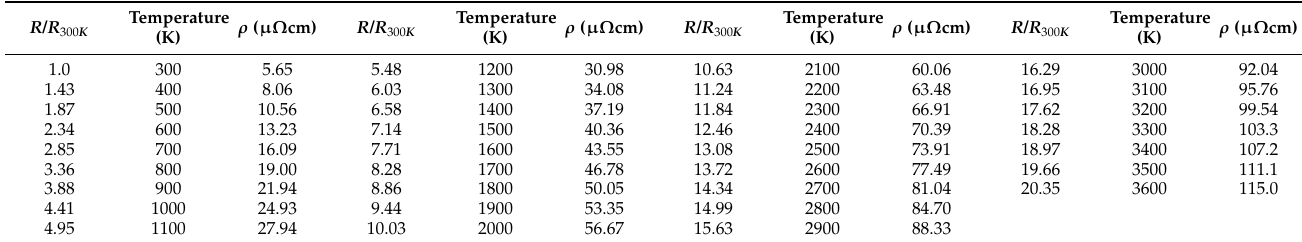
Table 1. Tungsten resistivity and ratio with temperature.